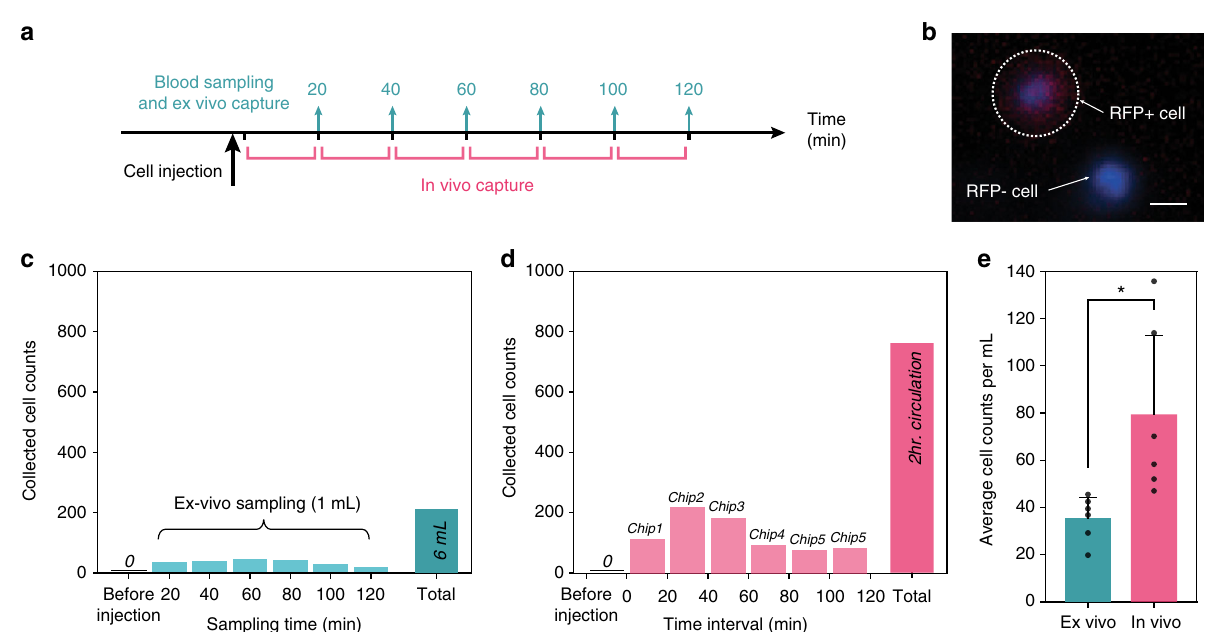
Fig. 4 Comparison of MCF7 cells detected by ex vivo versus in vivo CTC isolation method. a Schematic illustrating the work fl ow of the experiment. b Fluorescence microscope image of RFP transfected MCF7 cell with RFP negative leukocyte. The scale bar represents 10 µ m. c Number of MCF7 cells collected from six serial sampling of blood and its total by ex vivo isolation using the HB GO chip. d MCF7 counts from six serial chips replaced during in vivo cell enrichment and its total number of cells. e Comparison between total number of cells recovered per mL from ex vivo versus in vivo isolation method (data points are means ± s.d., n = 3, two-tailed paired t -test P < 0.05*, t = 3.39). Source data are available in the Source Data fi